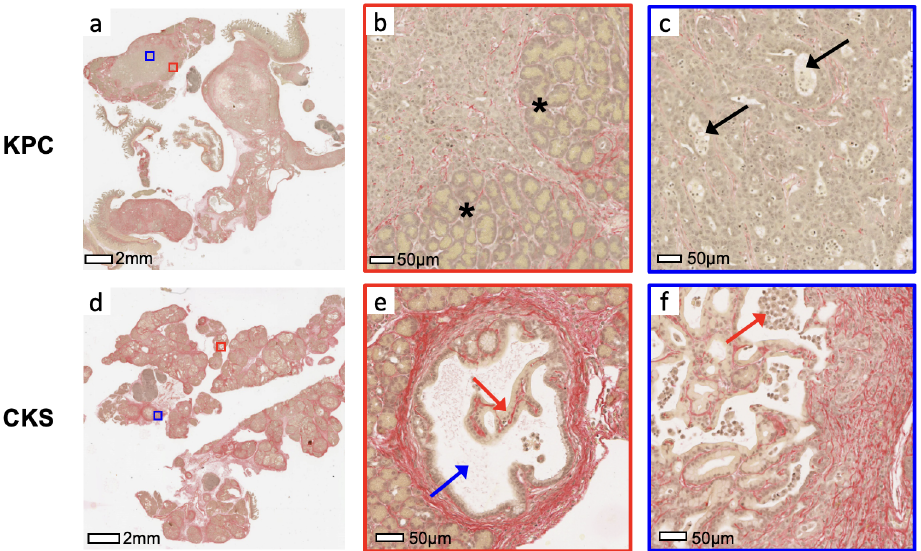
Figure 4. Sirius red staining of a KPC and CKS tumor. Sirius red staining of KPC tumor specimen ( a ) reveals collagen (stained red) deposition around tumor cells and residual pancreatic glands (* in b ). Glandular structures (arrows in c ) are formed by surrounding tumor cells, with necrotic tumor cells are seen inside the glandular space. In CKS tumor specimen ( d ), strong depositions of collagen fibers are found surrounding the pancreatic ducts ( e ), with tumor cells (red arrow) growing inside the lumen (blue arrow) folding and forming a papillary architecture. Magnified region ( f ) shows collagen depositions are also found surrounding and tumor nodules and the papillary formation of necrotic tumor cells inside expanded ducts (red arrow).